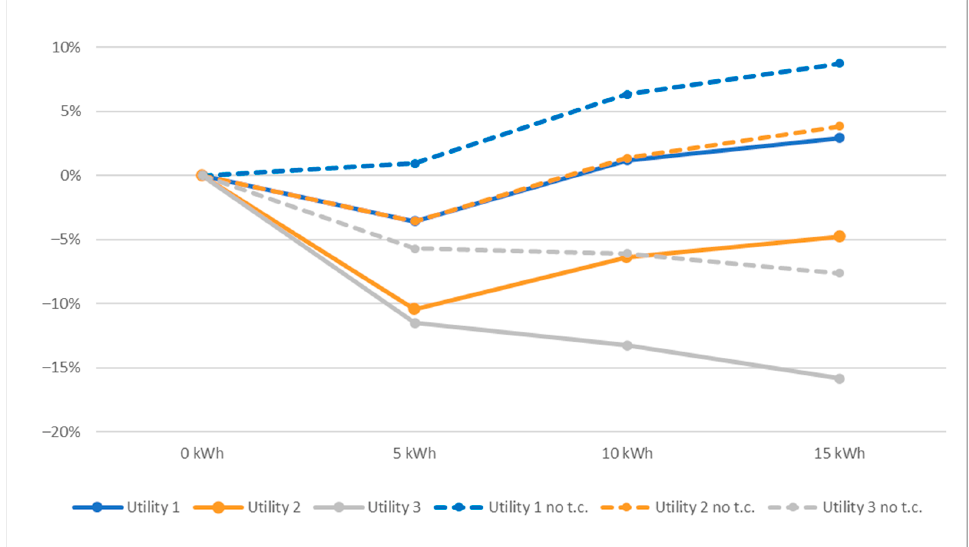
Figure 11. Annual net savings with and without tax credit for load 1, compared to GRID-PV-Only. The profitability of GRID-PV-BAT systems was also studied for higher demand charges by doubling the demand fees for utilities 1 and 2. Figure 12 shows the savings compared to the reference system (ONLY-GRID). The savings decreased for the GRID-PV-ONLY system, while the savings for the GRID-PV-BAT systems increased. Figure 13 shows the impact of the battery size on the changes in savings compared to GRID-PV-ONLY. With the doubled demand charges, all GRID-PV-BAT systems had equal or greater savings than the GRID-PV-ONLY solution. GRID-PV-BAT solutions with 10 kWh or 15 kWh had significantly higher savings than the GRID-PV-ONLY system.